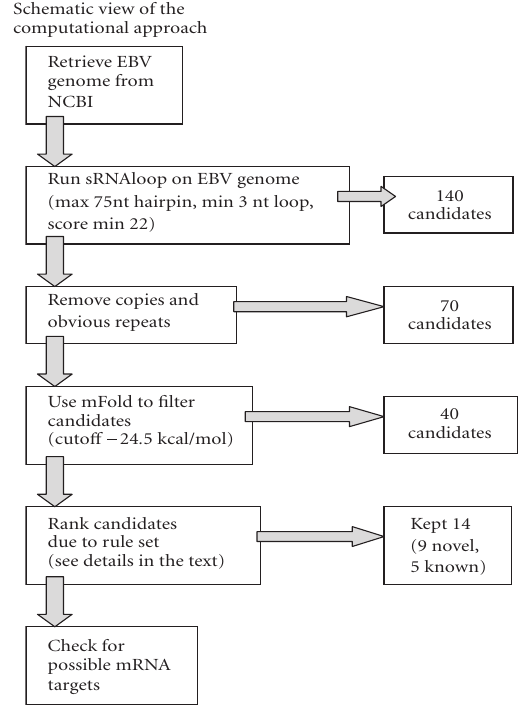
Figure 3: Schematic view of the computational